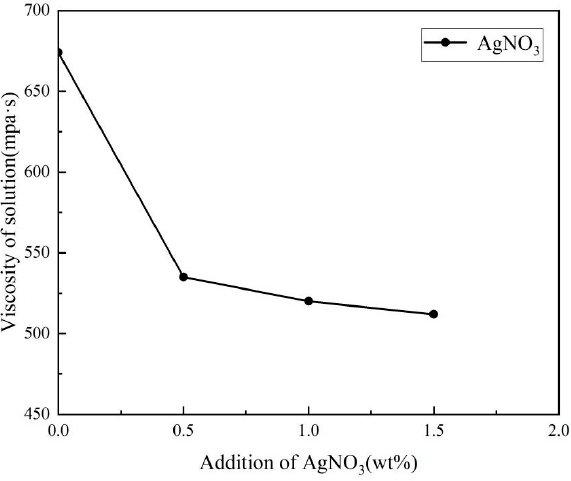
Figure 3. The viscosity of electrospinning solution with different addition of AgNO 3.